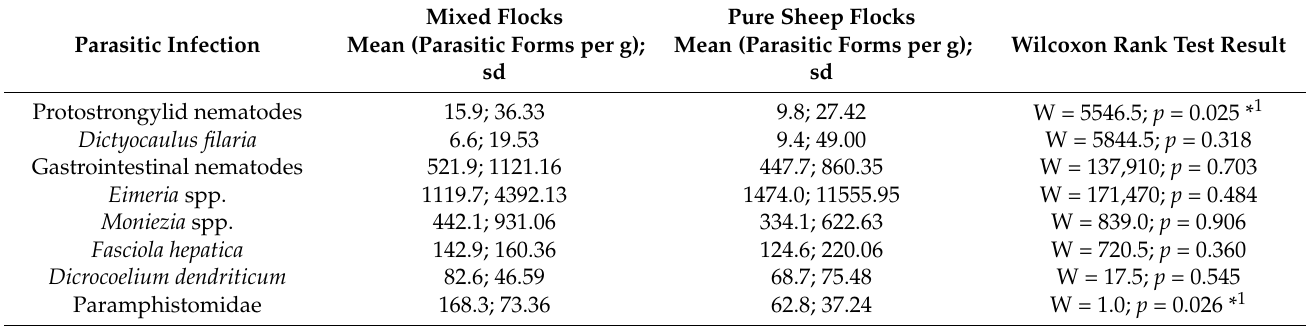
Table 3. Intensity of infection in mixed and pure sheep flocks and results of Wilcoxon rank test depending on goat contact. Pure Sheep Flocks Mixed Flocks Mean (Parasitic Forms per g); Wilcoxon Rank Test Result Parasitic Infection Mean (Parasitic Forms per g); sd sd Protostrongylid nematodes 15.9; 36.33 9.8; 27.42 Dictyocaulus